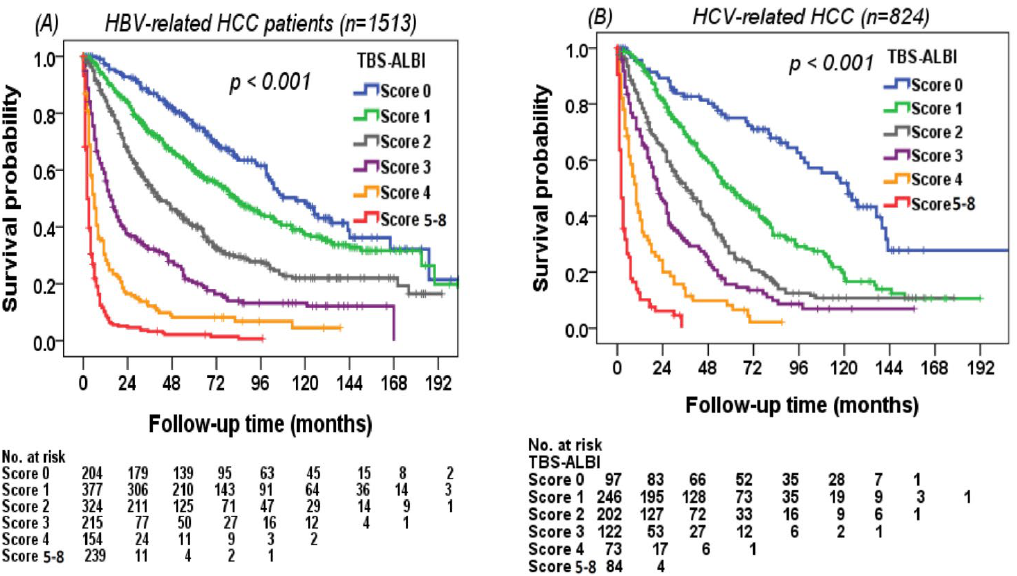
Figure 3. Survival distribution according to the TBS–ALBI system in ( A ) HBV-related HCC and ( B ) HCV-related HCC. Significant survival differences were found between different TBS–ALBI score groups in HBV-related ( p < 0.001; n = 1513) and HCV-related HCC ( p < 0.001, n = 824).